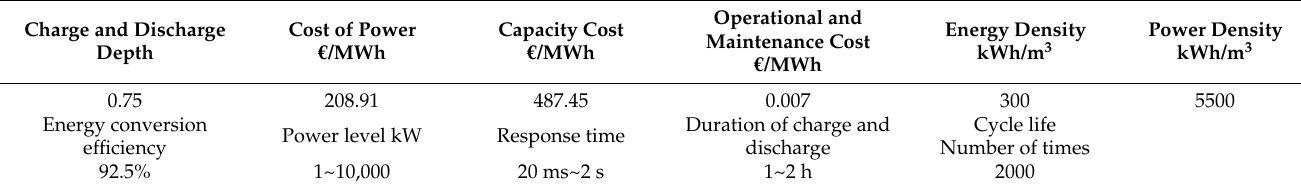
Table 3. Parameters of lithium iron phosphate energy storage battery.